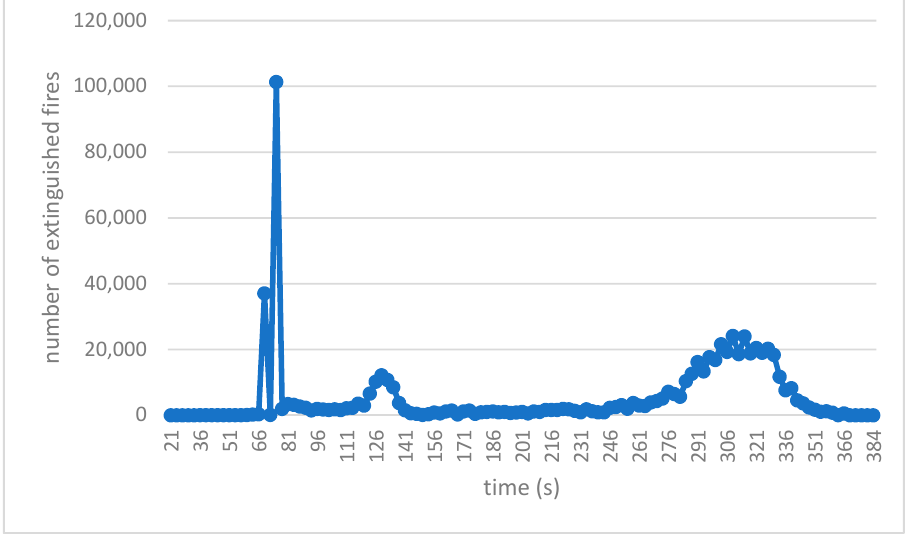
Figure 5. Time required to extinguish all 650,880 simulated fires.